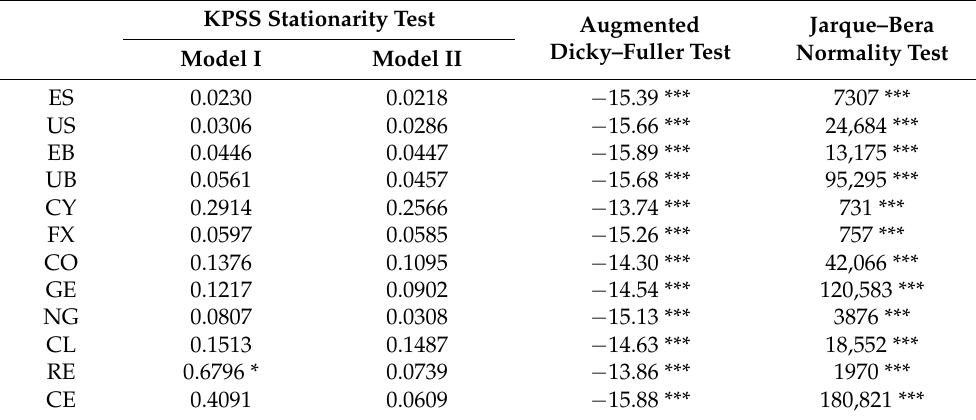
Table 2. Results of Stationarity and Normality